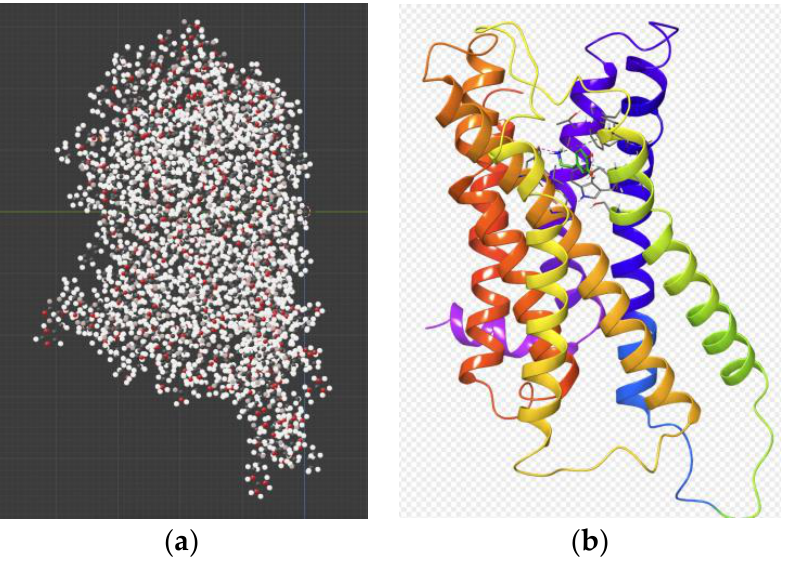
Figure 4. The visualization of a large protein as ( a ) the 3D point cloud molecule, and ( b ) the spiral structure of the resulting protein.